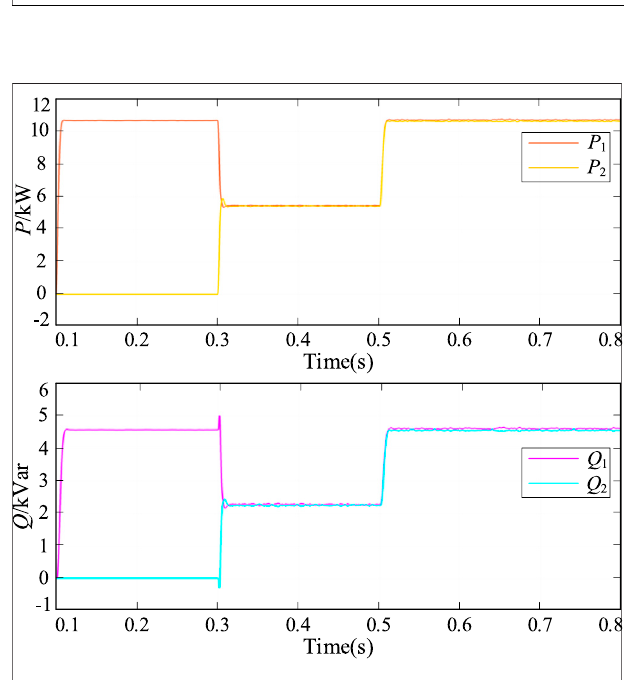
FIGURE 16 | Active and reactive power output of the inverter. Line impedance is different.